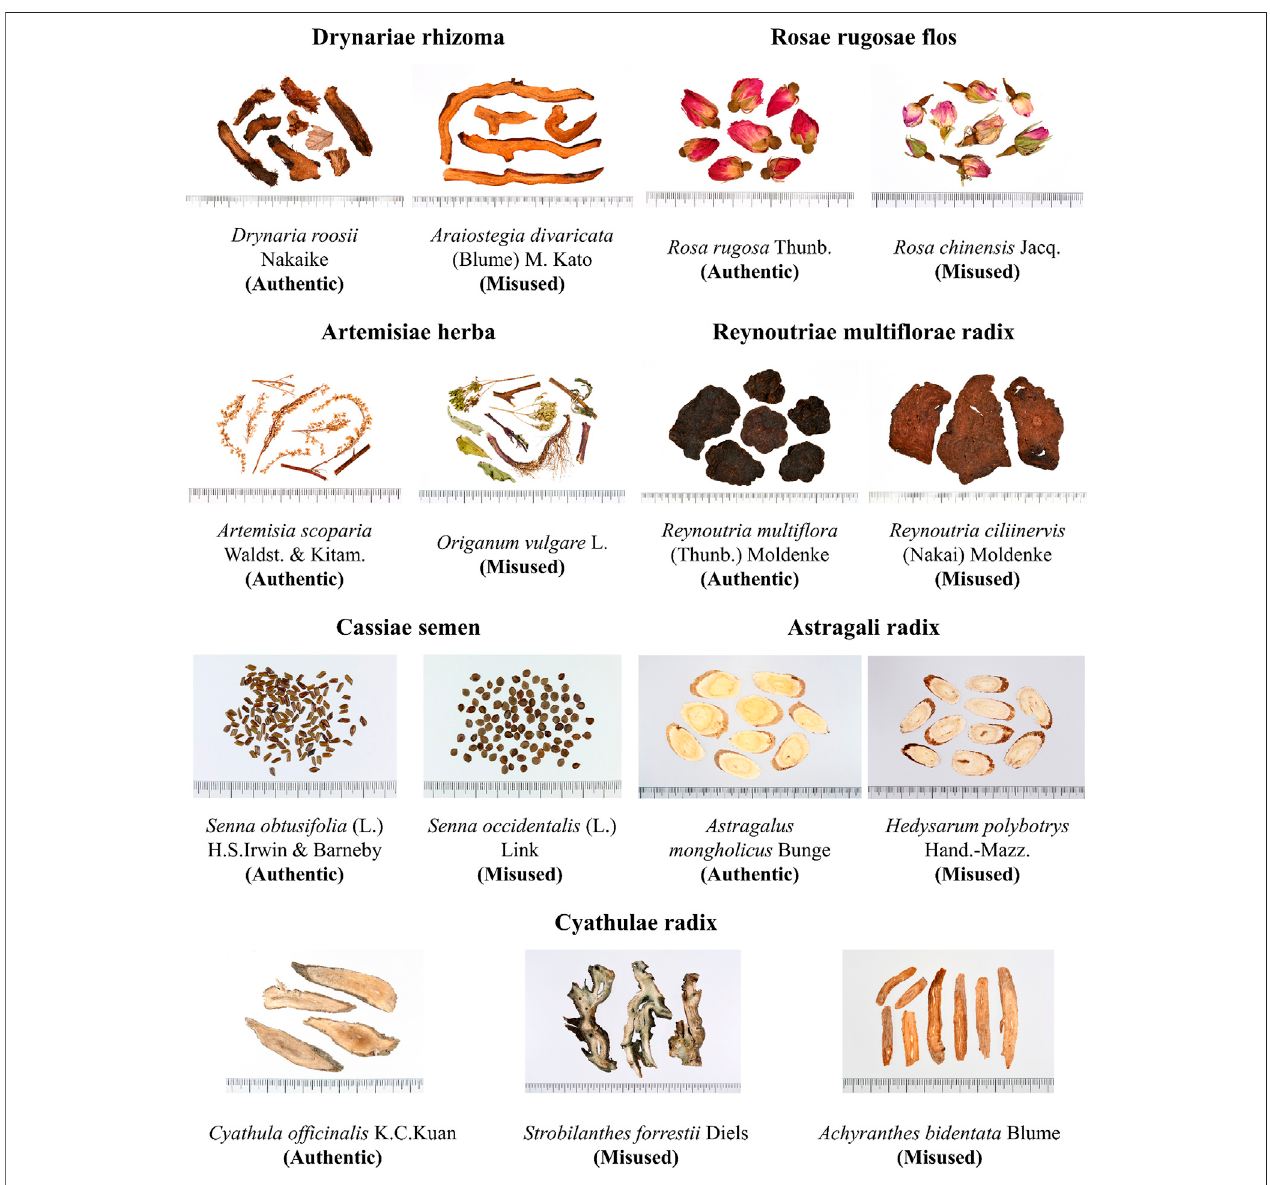
FIGURE 6 | Photograph of authentic and misused medicinal